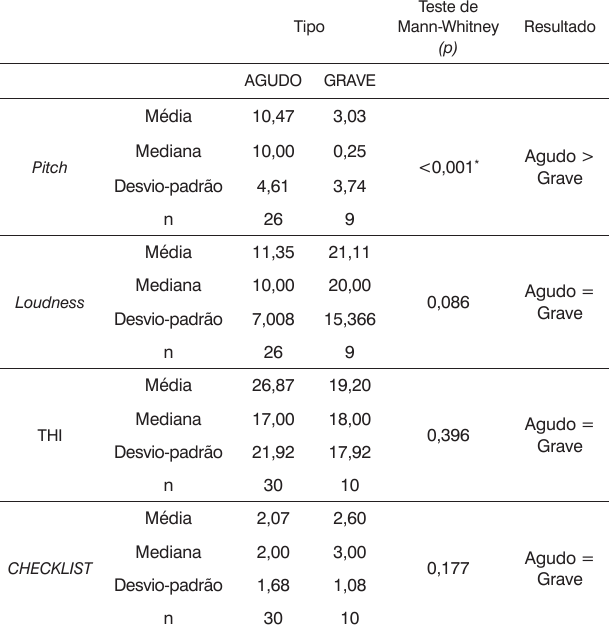
Tabela 5. Relação do tipo de zumbido, pela análise comparativa entre agudo e grave, para os parâmetros pitch , loudness , THI